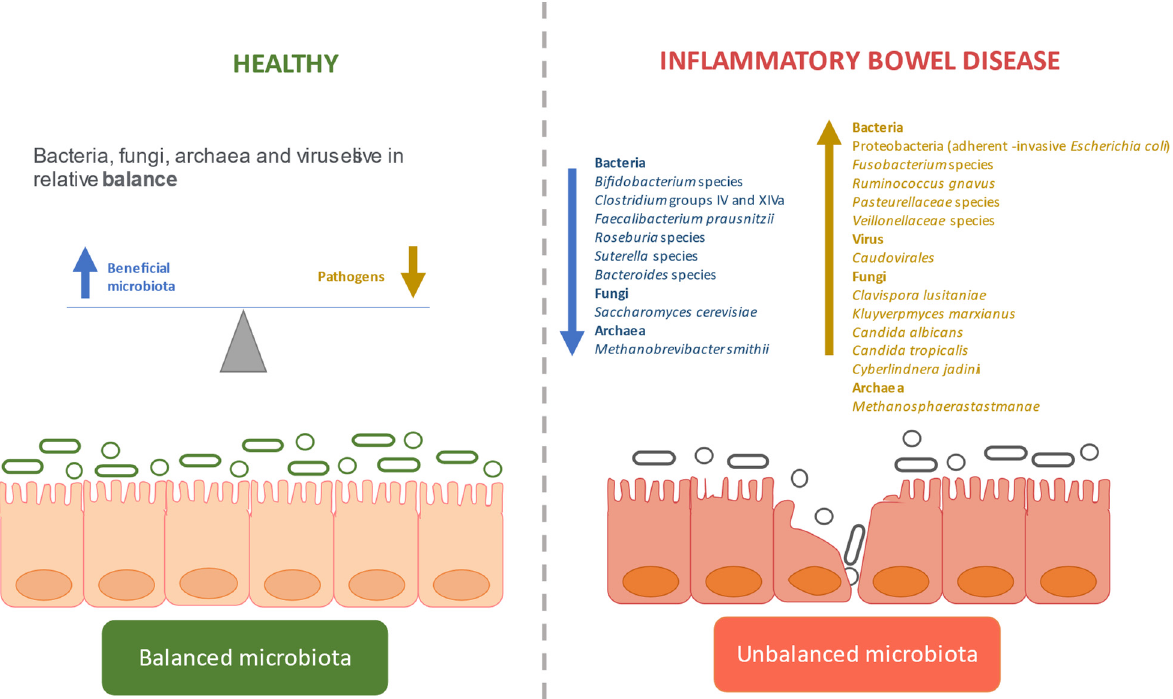
Figure 1. Gut microbiota disturbance in inflammatory bowel disease compared to healthy individuals. Upward arrow indicates increase and downward arrow decrease.